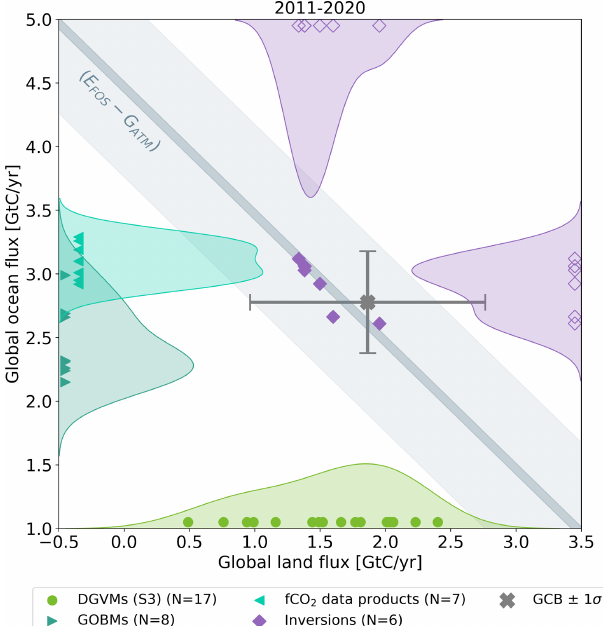
Figure 11. The 2011–2020 decadal mean net atmosphere–ocean and atmosphere–land fluxes derived from the ocean models and f CO 2 products ( y axis, right- and left-pointing blue triangles re- spectively) and from the DGVMs ( x axis, green symbols), and the same fluxes estimated from the six inversions (purple symbols on secondary x and y axis). The grey central point is the mean ( ± 1 σ ) of S OCEAN and ( S LAND − E LUC ) as assessed in this budget. The shaded distributions show the density of the ensemble of individual estimates. The grey diagonal band represents the fossil fuel emis- sions minus the atmospheric growth rate from this budget ( E FOS − G ATM ). Note that positive values are CO 2